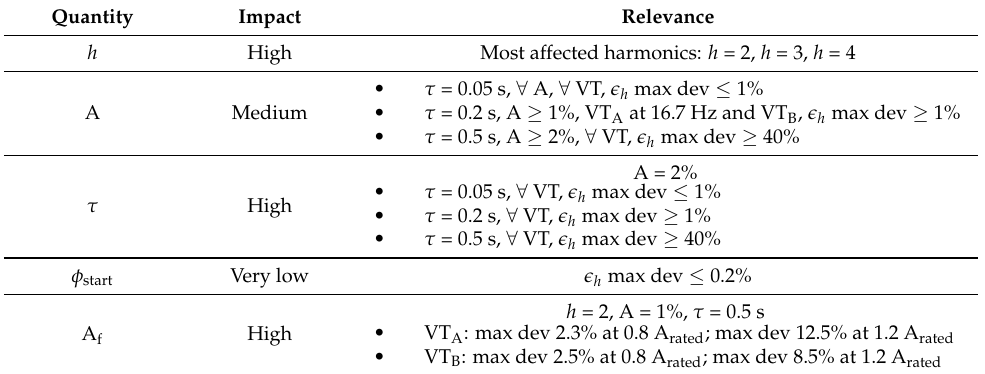
Table 4. Summary of the results obtained from the experimental